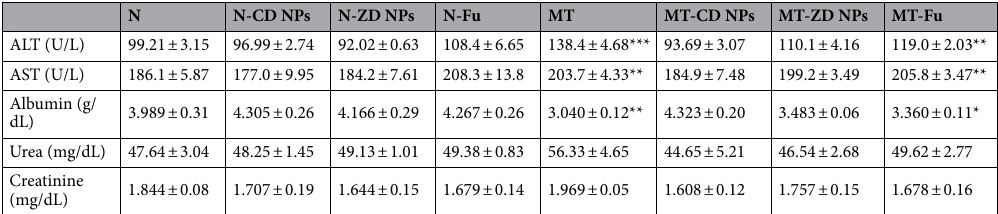
Table 1. Liver and kidney functional parameters. N the untreated healthy control normal mouse group, N‑CD NPs nanocomplex of Cu 4 O 3 with diethyldithiocarbamate (DE)-treated normal mouse group, N‑ZD NPs nanocomplex of ZnO with DE-treated normal mouse group, N‑Fu 5-fluorouracil-treated normal mouse group, MT the untreated mammary tumor-bearing mouse group, MT‑CD NPs CD NPs-treated MT group, MT‑ZD NPs ZD NPs-treated MT, and MT‑Fu Fu-treated MT group. All values are demonstrated as mean ± SEM. N group was compared to other groups and considered significantly different at p < 0.05*, < 0.01**, and < 0.0001***.